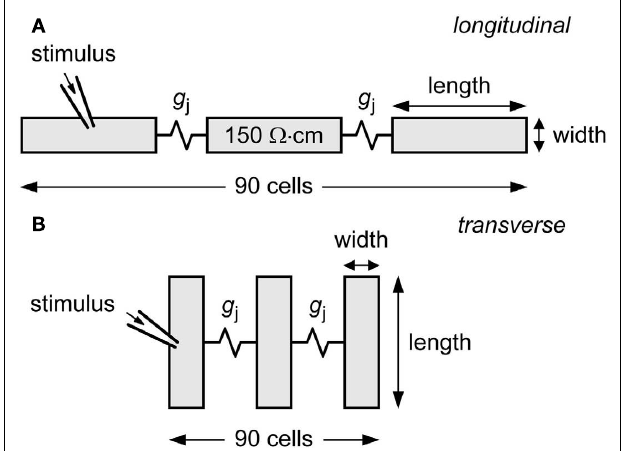
g j . Myoplasmic resistivity is set to 150 Ω cm. Action potential propagation is initiated by applying an external stimulus to the leftmost cell of the strand. (A) Cells arranged longitudinally. (B) Cells arranged